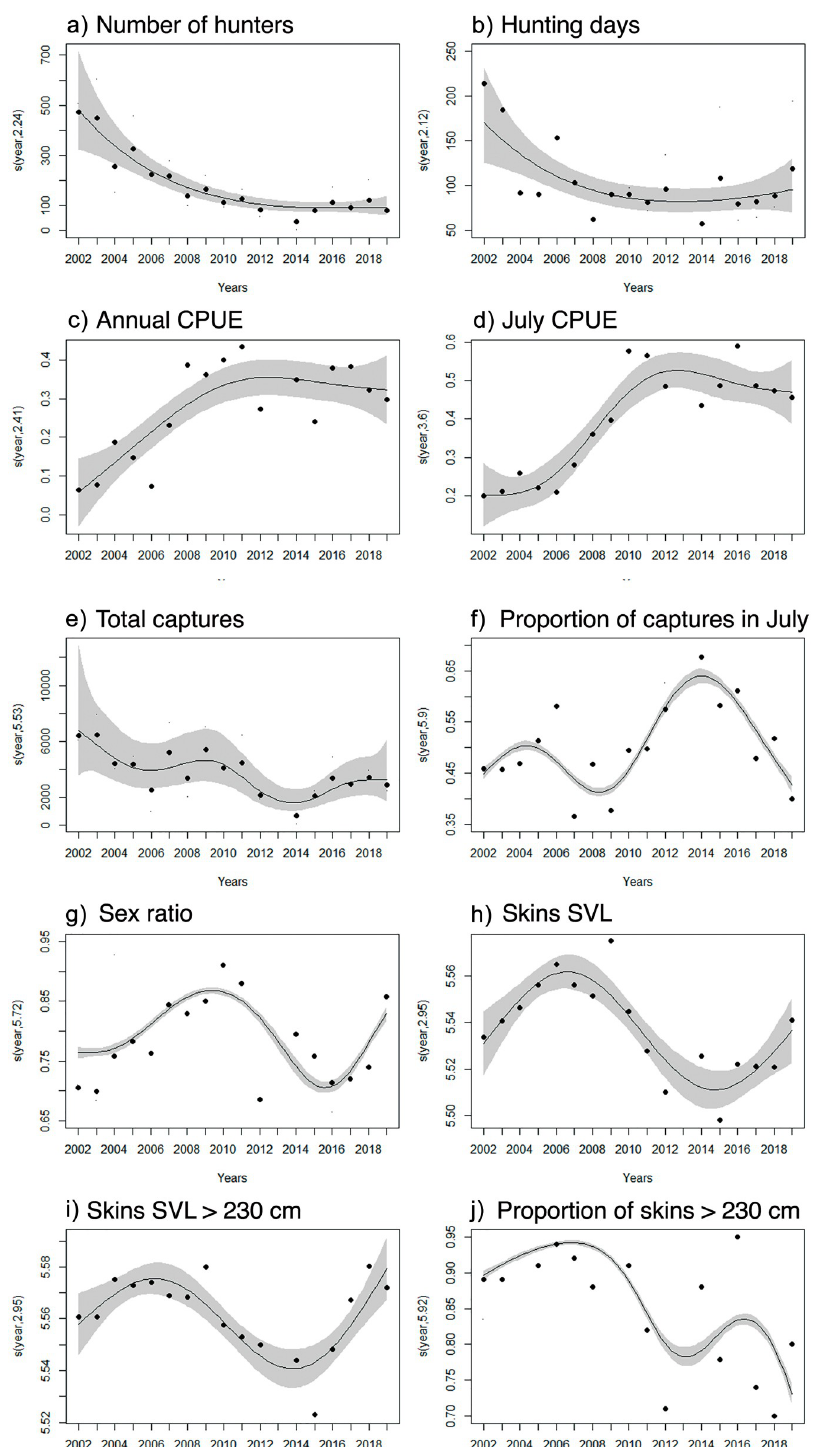
Fig 4. Smoothed trends of yellow anaconda ( Eunectes notaeus ) harvest parameters measured by the Programa Curiyú between 2002–2019 in northeastern Argentina. The y-axis represents the smooth term and the EDF value, and the grey area indicates the 95% confidence interval obtained from the Generalized Additive Models (GAMs).